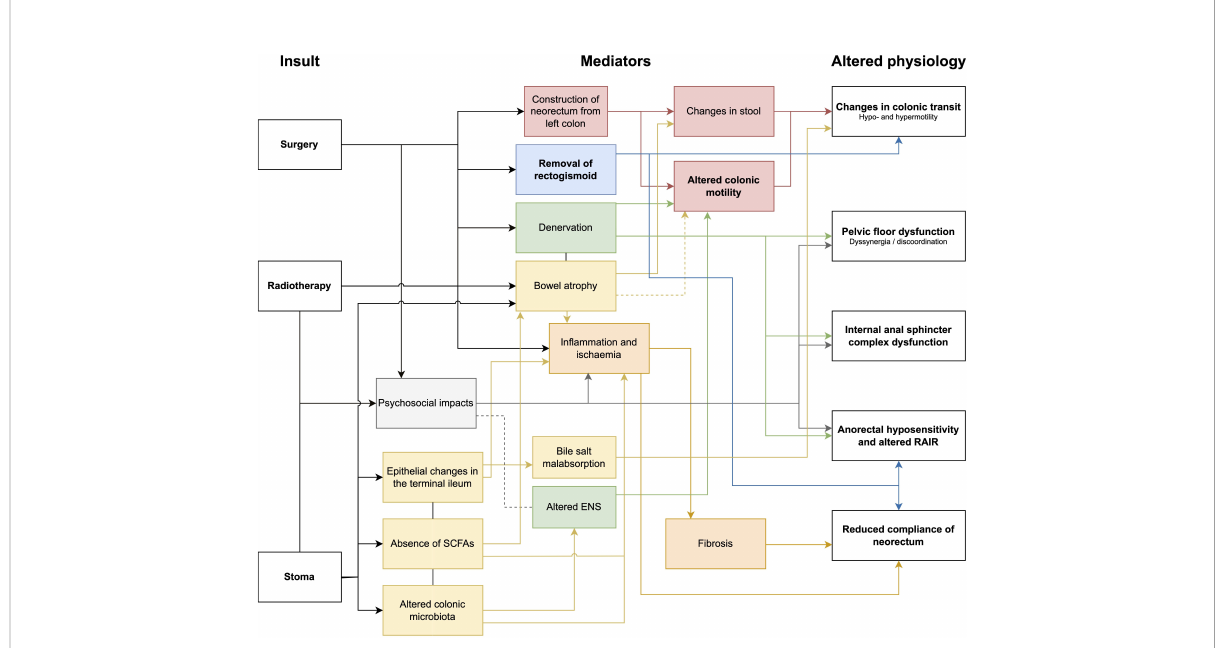
FIGURE 5 Flow diagram of mechanisms of injury as a consequence of surgery, radiotherapy and stoma formation. SCFA, short chain fatty acids; ENS, enteric nervous system; rectoanal inhibitory re fl ex, RAIR.